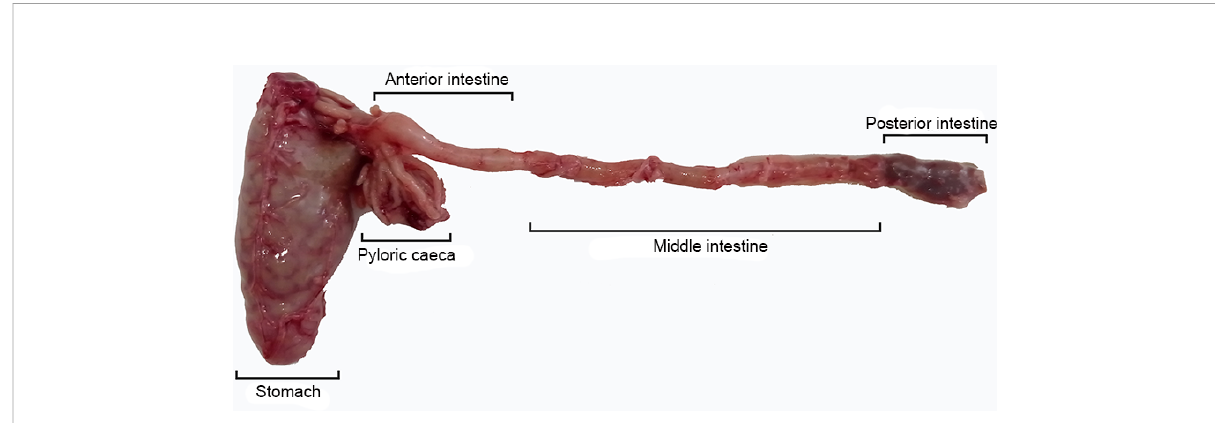
FIGURE 1 Digestive tract of a Seriola dumerili juvenile indicating the dissected regions for digestive enzymes